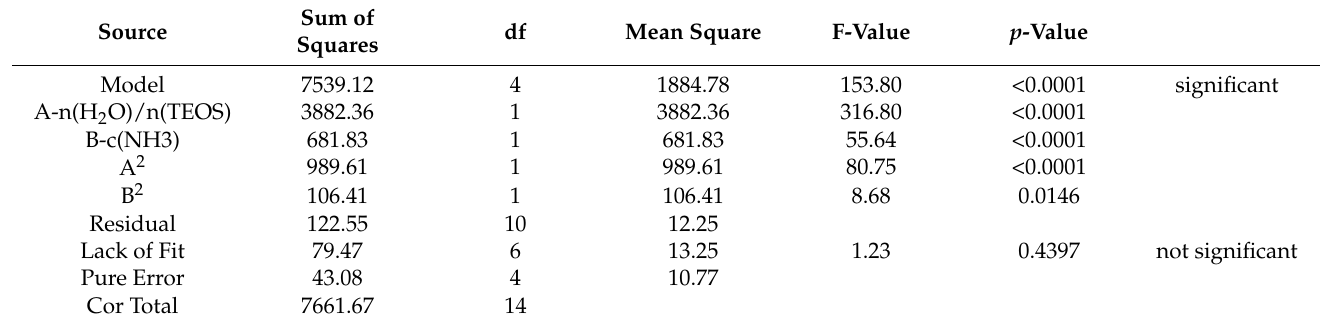
Table A4. Analysis of variance (ANOVA) for the analysis of the FCD design of the SSA.